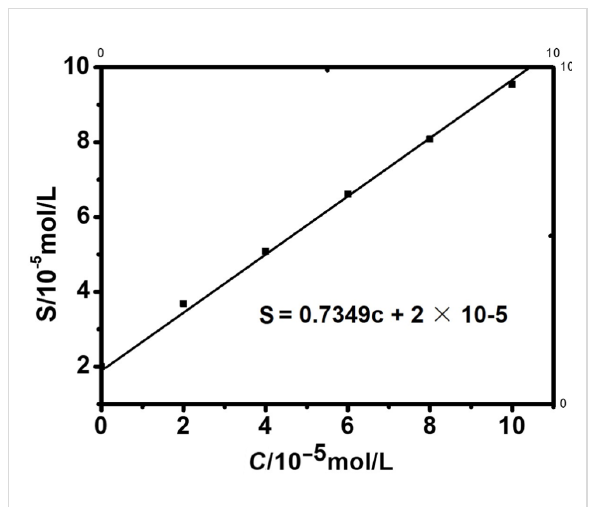
Figure 8: The phase solubility graph obtained for BALE in Q[8] at λ = 270